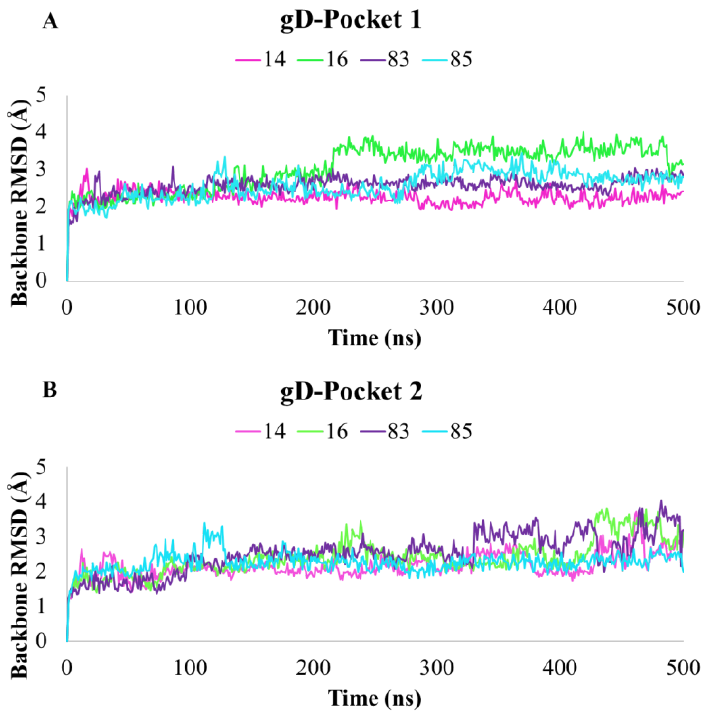
Figure 8. RMSD plots of 14 , 16 , 83 , and 85 compounds in complex with ( A ) gD-Pocket 1 and ( B ) gD-Pocket 2, calculated on protein’s backbone atoms during 500 ns of MDs.